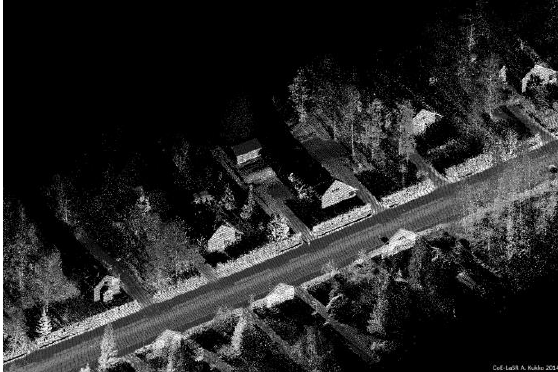
Figure 3. Detail of the street measurements, points coloured by the laser intensity.